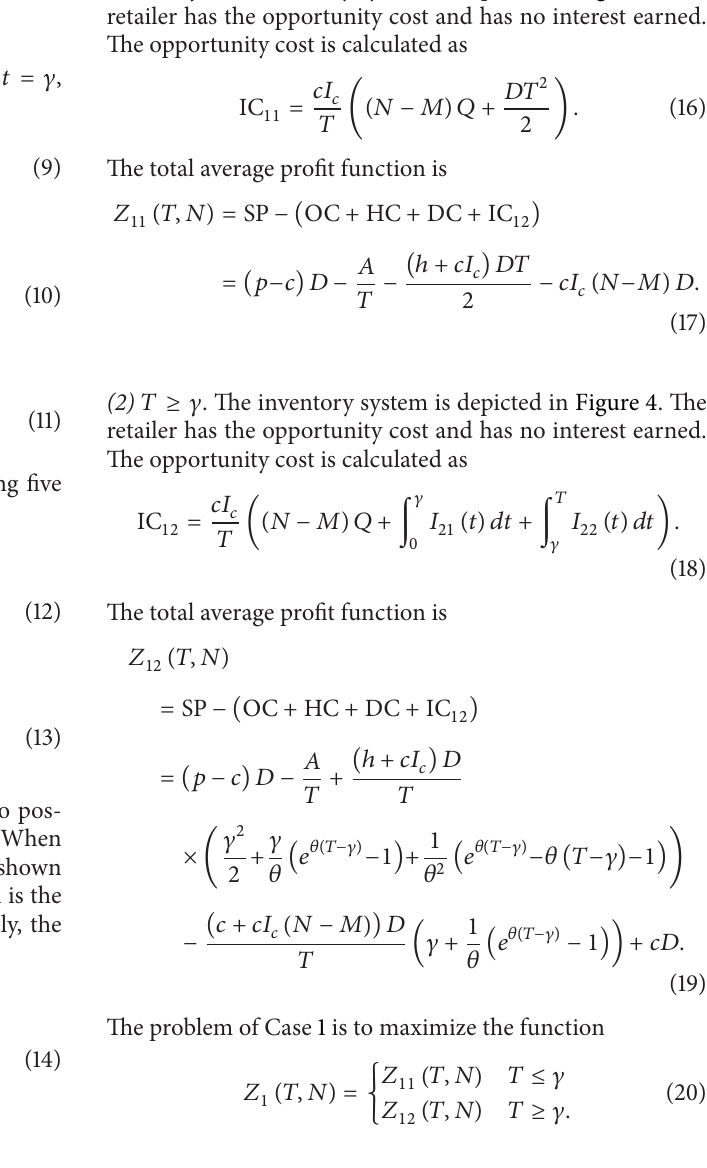
Figure 2: Inventory system for 𝑇 ≥ 𝛾